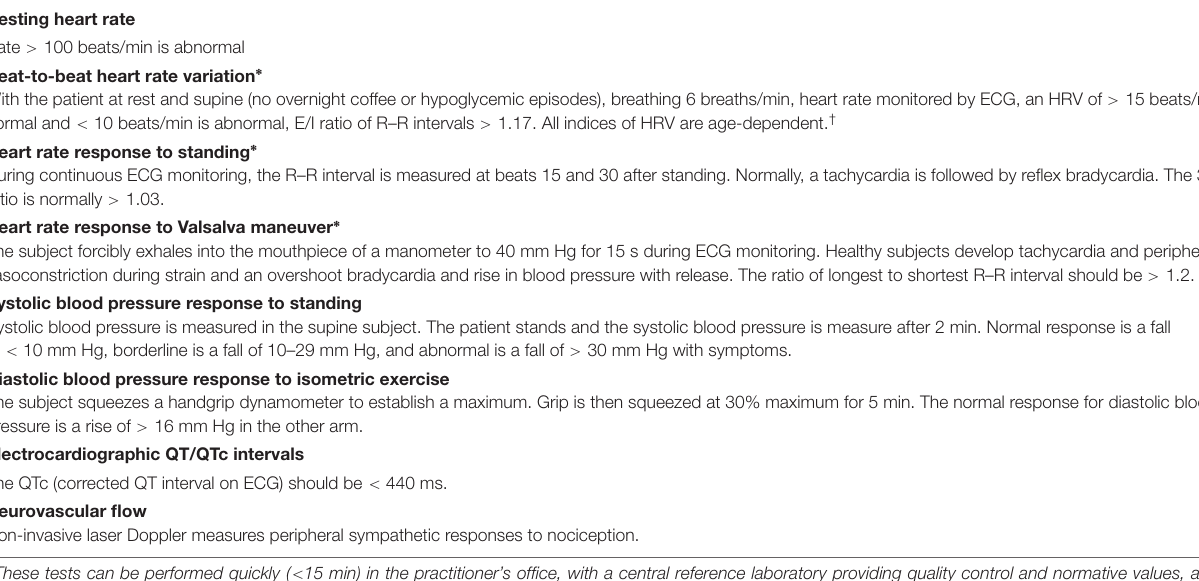
TABLE 1 | Diagnostic tests for cardiovascular autonomic neuropathy (adapted from Brownlee et al., 2016). Resting heart rate Rate > 100 beats/min is abnormal Beat-to-beat heart rate variation ∗ With the patient at rest and supine (no overnight coffee or hypoglycemic episodes), breathing 6 breaths/min, heart rate monitored by ECG, an HRV of > 15 beats/min is normal and < 10 beats/min is abnormal, E/I ratio of R–R intervals > 1.17. All indices of HRV are age-dependent. †